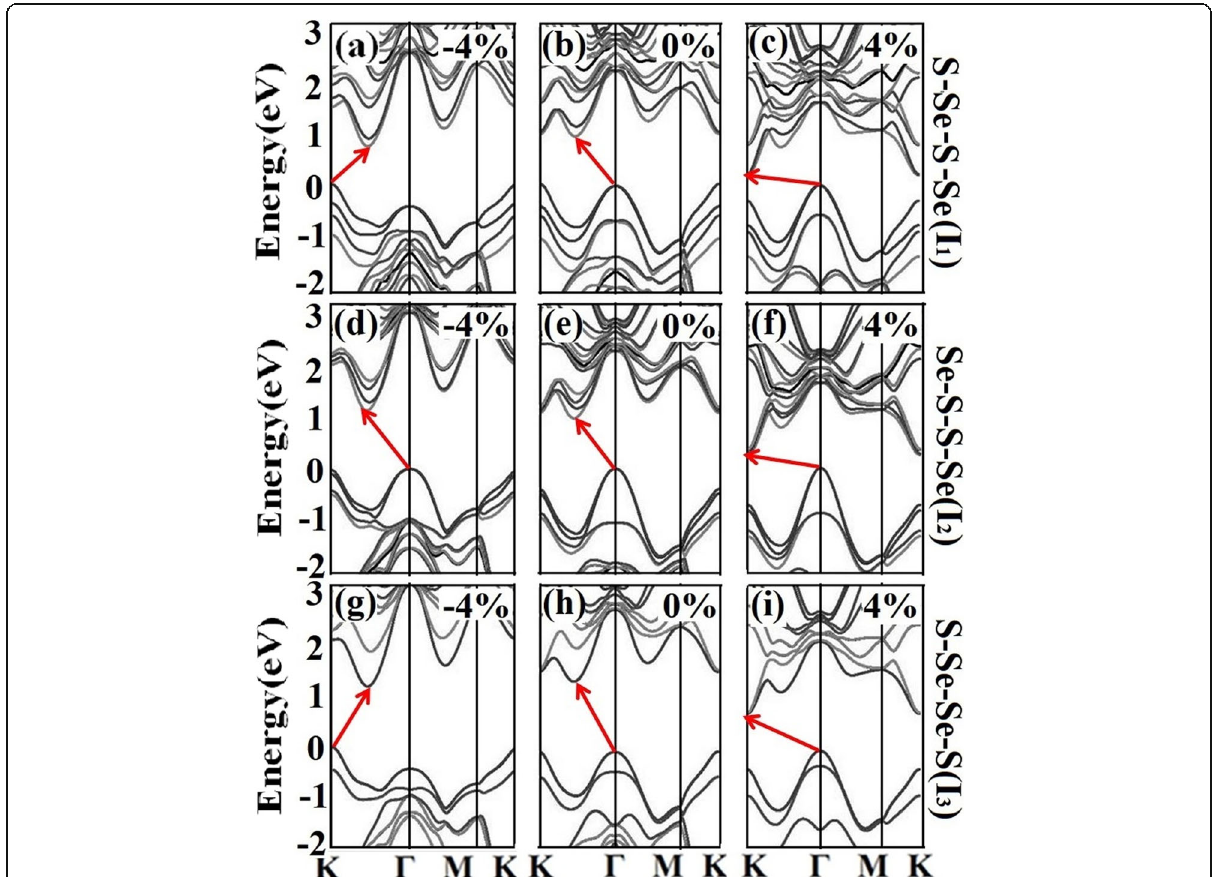
Fig. 7 a – i Band structures of I 1 , I 2 , and I 3 under the strains of − 4%, 0, and 4% with the consideration of SOC effect, where the black and blown colors mean the up and down spins, respectively. The bandgaps are denoted by the red